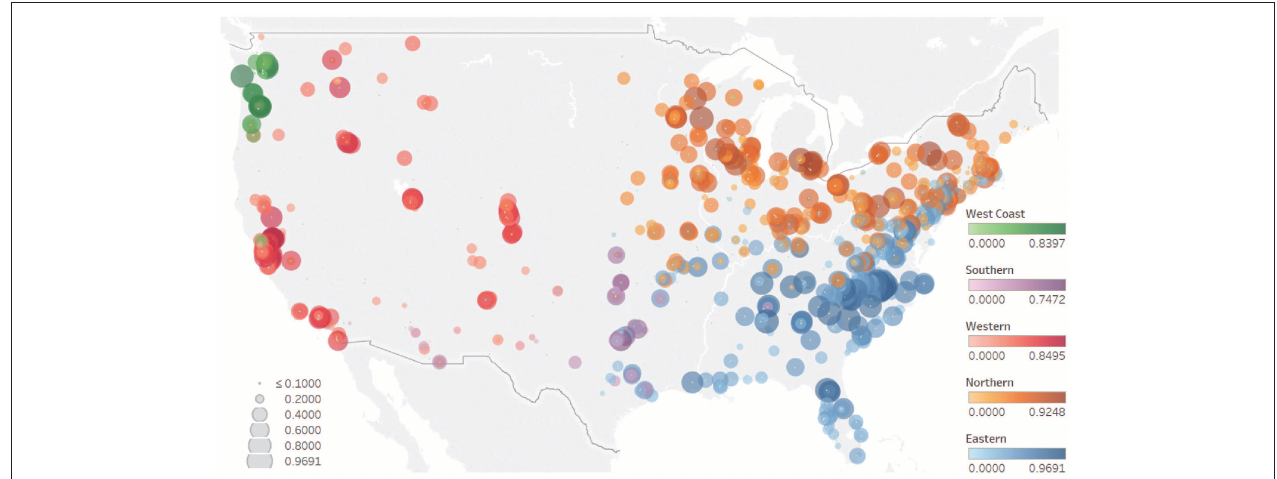
FIGURE 3 | Map showing the results of the Latent Dirichlet Allocation (LDA) model. Size represents the probability of each dust sample being associated with a particular partition. Color represents the geographical partition: Northern (orange), Eastern (blue), Southern (purple), Western (red), and West Coast (green).